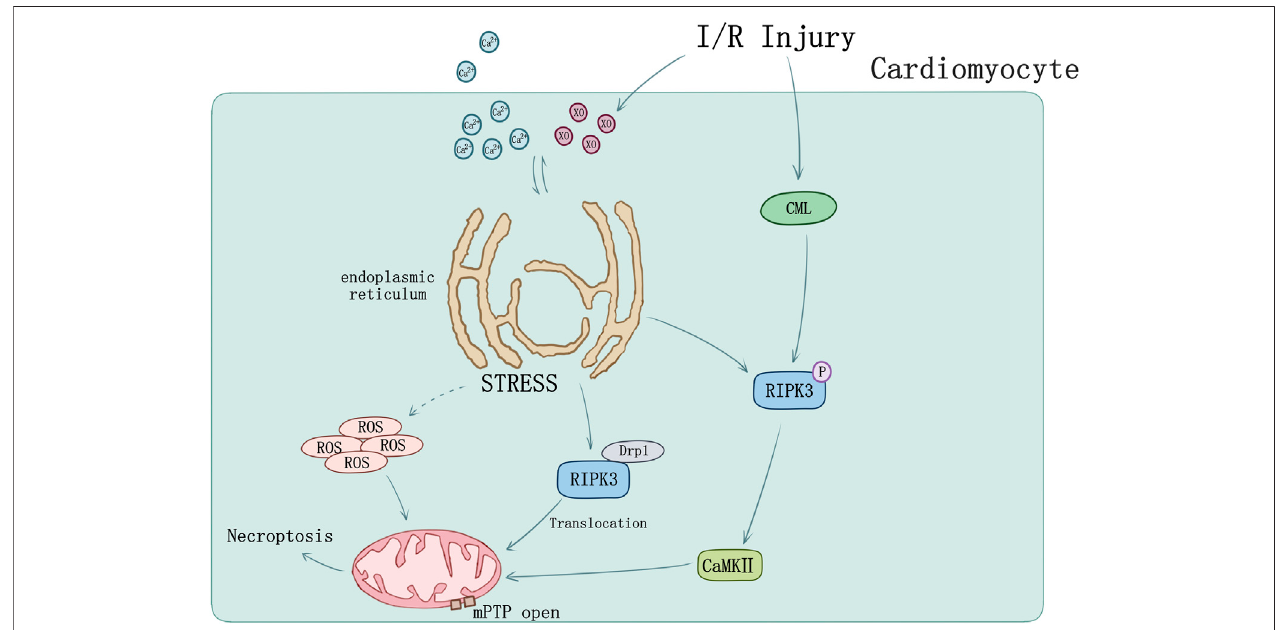
FIGURE3| Ischemia-reperfusioninjuryandERstressinducedmyocardialnecroptosis.[Ca]andXOin fl uxcauseERstressandmediatedmPTPopeningbyraising ROS. RIPK3 phosphorylation can be induced by CML in I/R injury. Phosphorylation of RIPK3 could activate CaMKII and subsequently trigger opening of the mPTP. I/R could cause RIPK3 and Drp1 translocation from cytoplasm to mitochondrion.